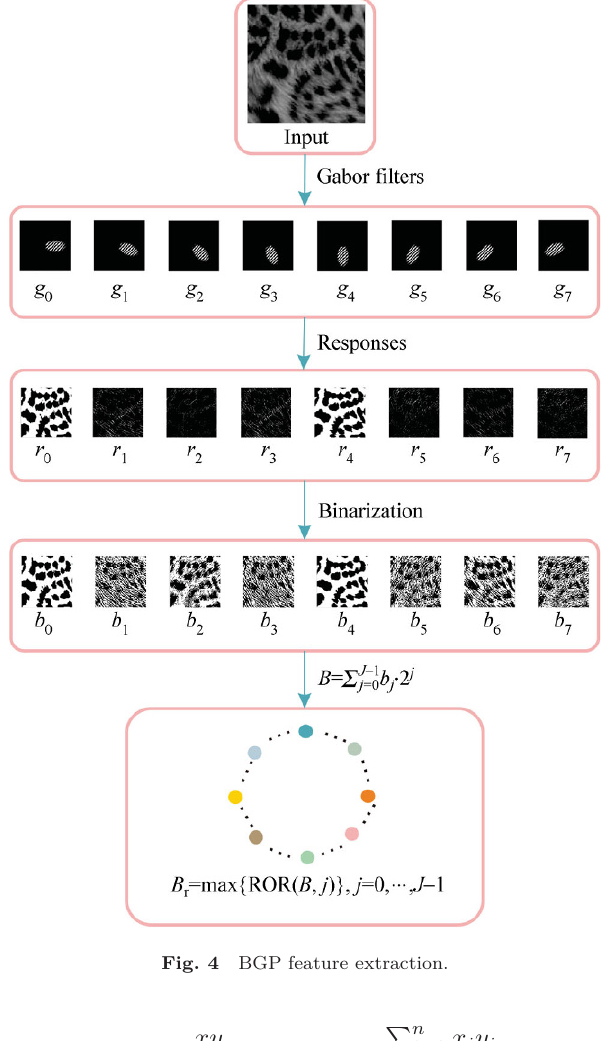
Fig. 4 BGP feature